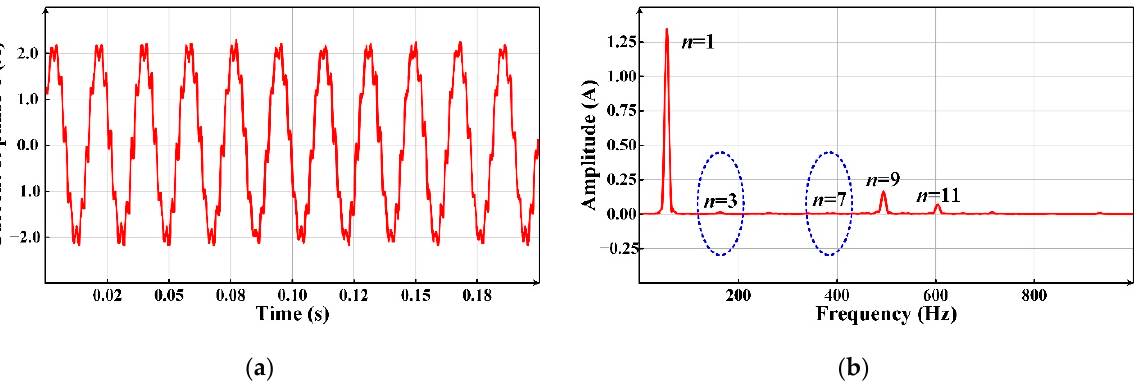
Figure 12. Harmonic current suppression results with fundamental currents, third harmonic cur- rent and seventh harmonic current: ( a ) phase-1 current; ( b ) DFT results. Table 3. Harmonic current suppression results.